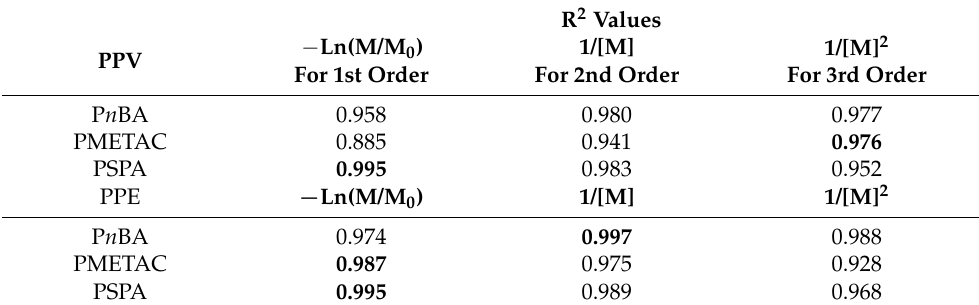
Table 1. R 2 values for the ATRP kinetics of macroinitiators for neutral (P n BA), cationic (PMETAC) and anionic (PSPA) grafts. Values are determined through linear regression of the column titles against time. The R 2 values closest to 1 are bolded for each row. R 2 Values − Ln(M/M 1/[M] 1/[M] 2 0 ) PPV For 1st Order For 2nd Order For 3rd Order P n BA 0.958 0.980 0.977 PMETAC 0.885 0.941 0.976 0.995 0.983 0.952